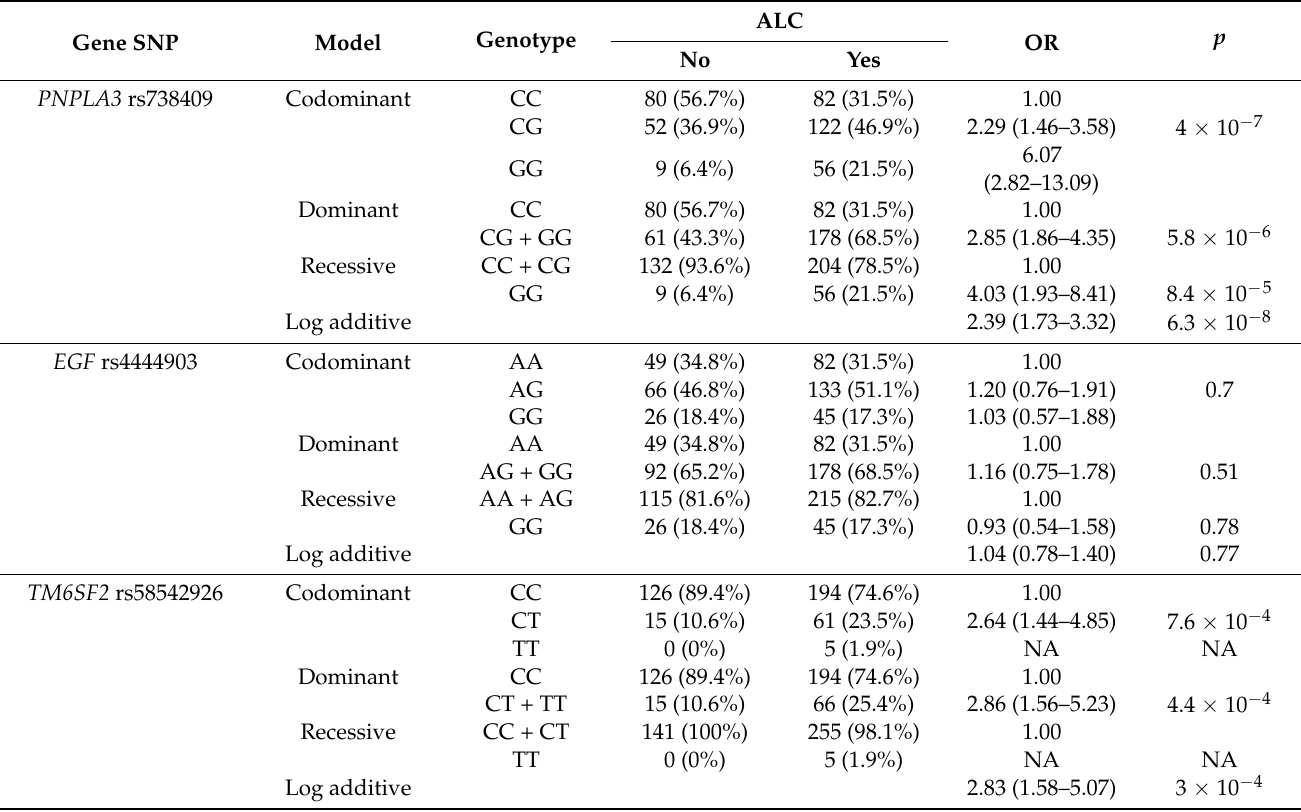
Table 2. Single nucleotide polymorphism-associated odds ratio for cirrhosis